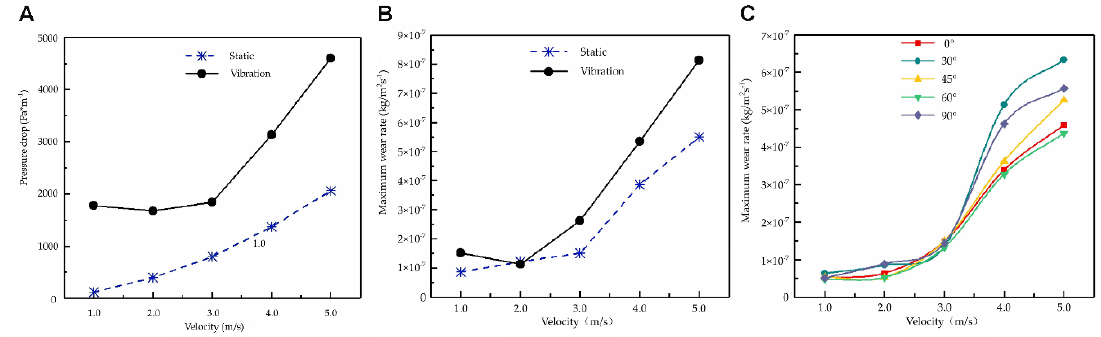
Figure 6. The e ff ects of flow velocity on pressure drop ( A ) and the maximum wear rate ( B , C Figure 6. The effects of flow velocity on pressure drop ( A ) and the maximum wear rate ( B , C ).